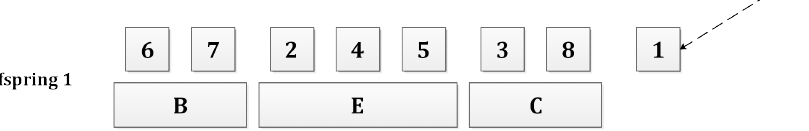
Figure 7. Delete the physical machines containing duplicate virtual machines.